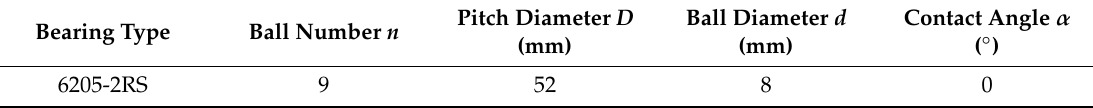
Table 7. Bearing parameter of 6205-2RS deep groove ball bearing.